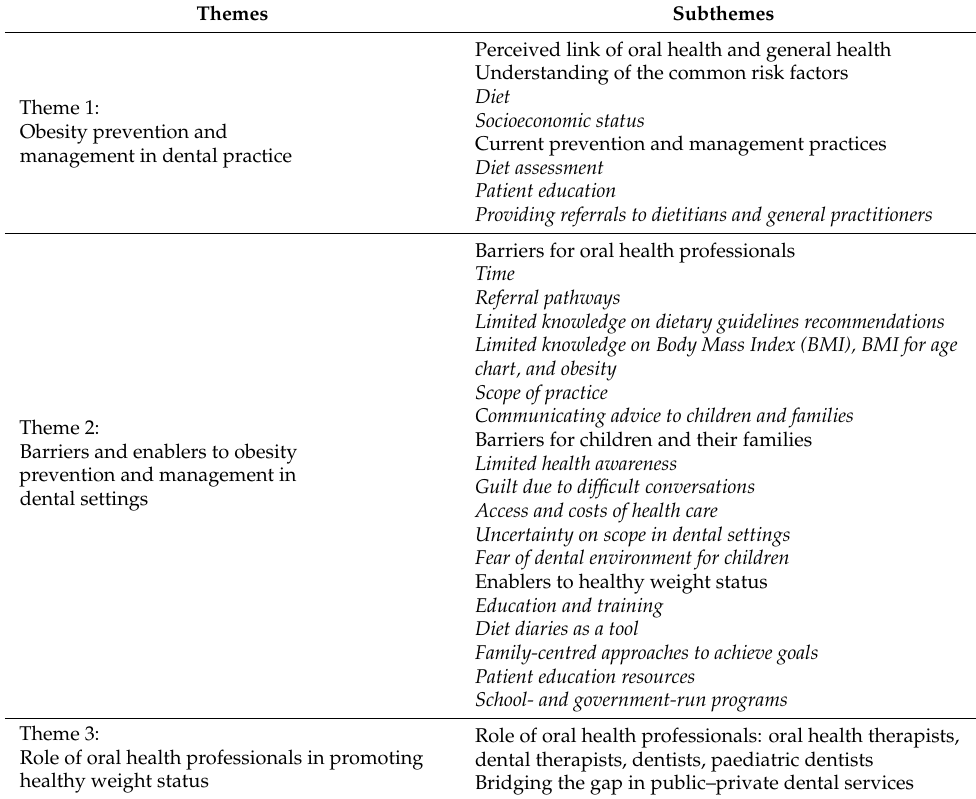
Table 1. Themes and